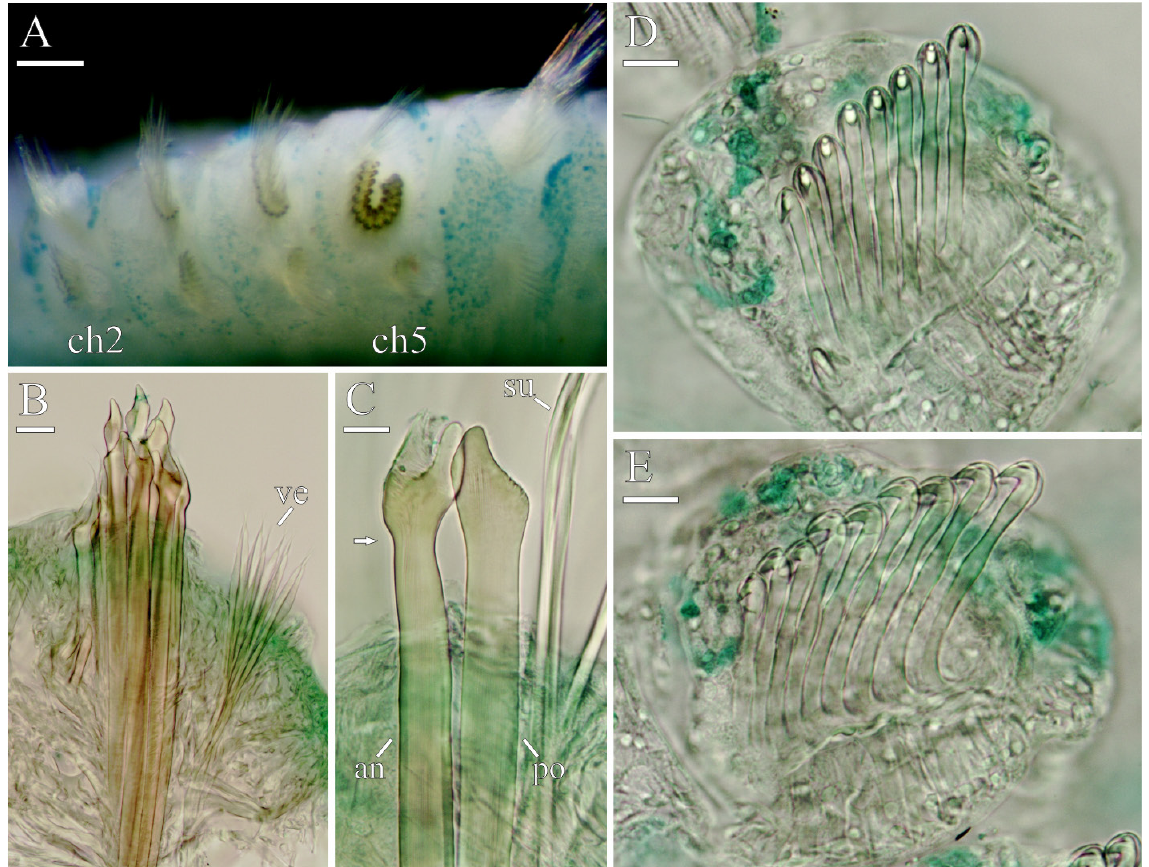
Fig. 6. Chaetal morphology of Pseudopolydora antennata (Claparède, 1868) (formalin-fixed and stained with MG specimens, MIMB 40895). A . Chaetigers 2–6, left lateral view, showing mirror reflected J-shaped arrangement of the anterior-row notochaetae in notopodia of chaetigers 3 and 4, and U-shaped arrangement of spines in notopodium of chaetiger 5. B . Parapodium of chaetiger 5, dorsal superior capillaries missing. C . Notochaetae of chaetiger 5. D – E . Series of bidentate hooded hooks from middle neuropodia, frontal (D) and lateral (E) view. Abbreviations: arrow showing the direction towards the inside of the U-shaped row of chaetiger 5 spines; an = anterior-row spine from notopodium of chaetiger 5; ch2 , ch5 = chaetigers 2 and 5; po = posterior-row spine from notopodium of chaetiger 5; su = dorsal superior capillary chaetae; ve = ventral capillary chaetae. Scale bars: A = 100 µm; B = 20 µm; C–E = 10